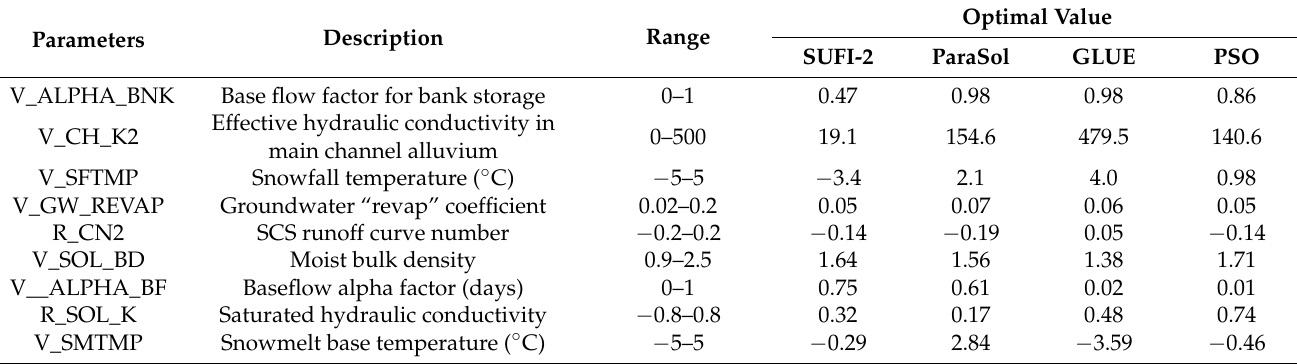
Table 2. Description and initial ranges of nine selected calibrated parameters and their final optimal values for SUFI-2, ParaSol, GLUE, and PSO